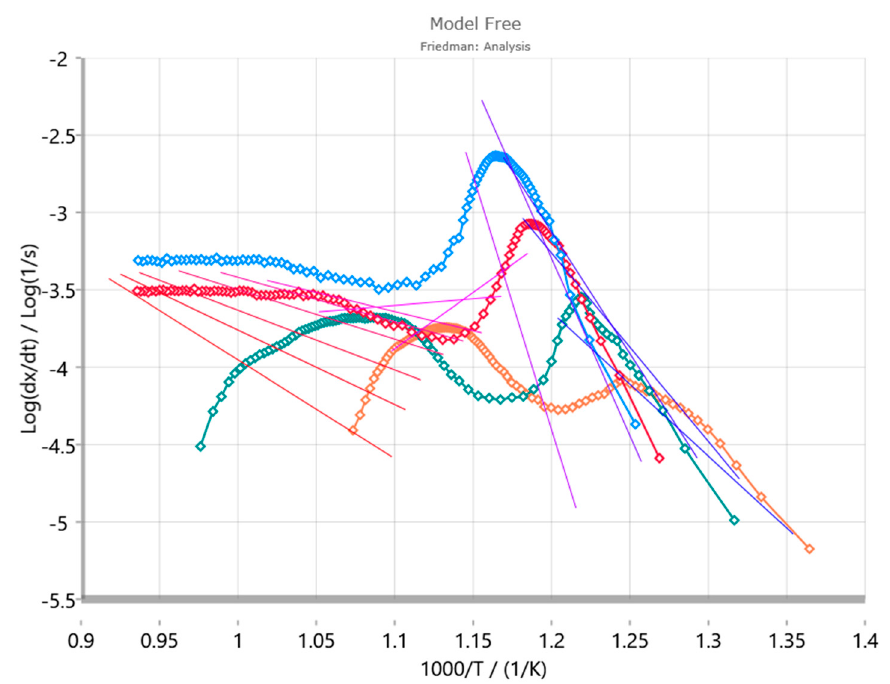
Figure 9. Friedman analysis of PEEK using 4 different heating rates under 2% oxygen (orange: 1 K/min, green: 2 K/min, red: 5 K/min, blue: 10 K/min).